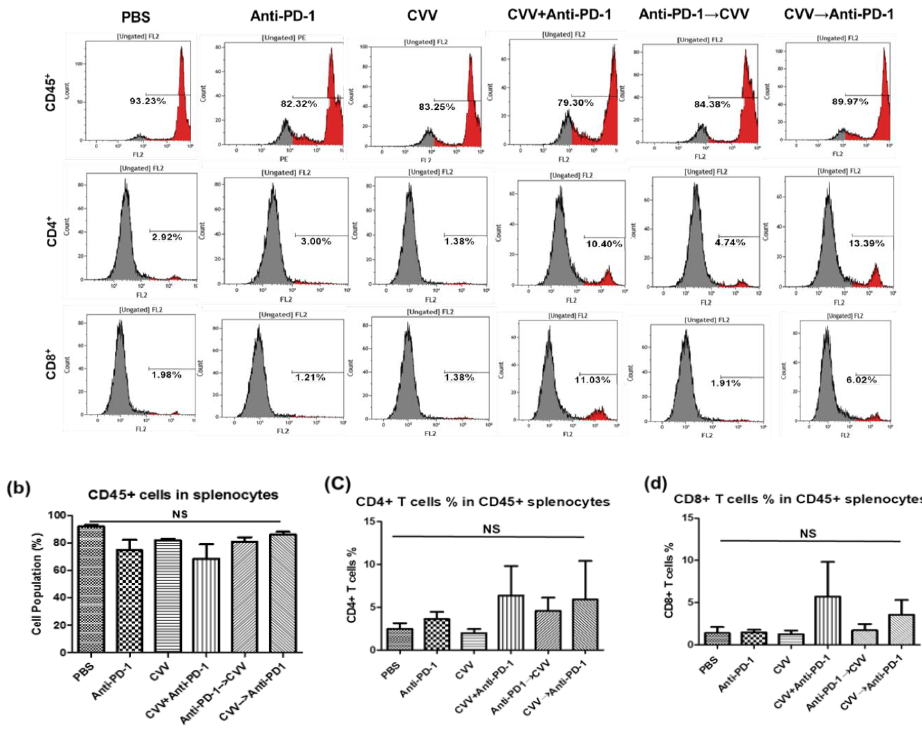
Figure 8. The central immune system is activated by simultaneous combination therapy. Splenocytes enumeration of CT26 tumor–bearing Balb / c mice. After 40 days, spleens were harvested from responders and a single-cell preparation was made for flow cytometry. CD45 + , CD8 + , and CD4 + cell populations were quantified. ( a ) Representative images of CD45 + , CD4 + , and CD8 + T-cell histograms in all six groups.( b ) Total number of CD45 + cells in splenocytes.( c ) CD4 + T-cells % in CD45 + cells in all six groups. ( d ) CD8 + T-cells % in CD45 + cells in all six